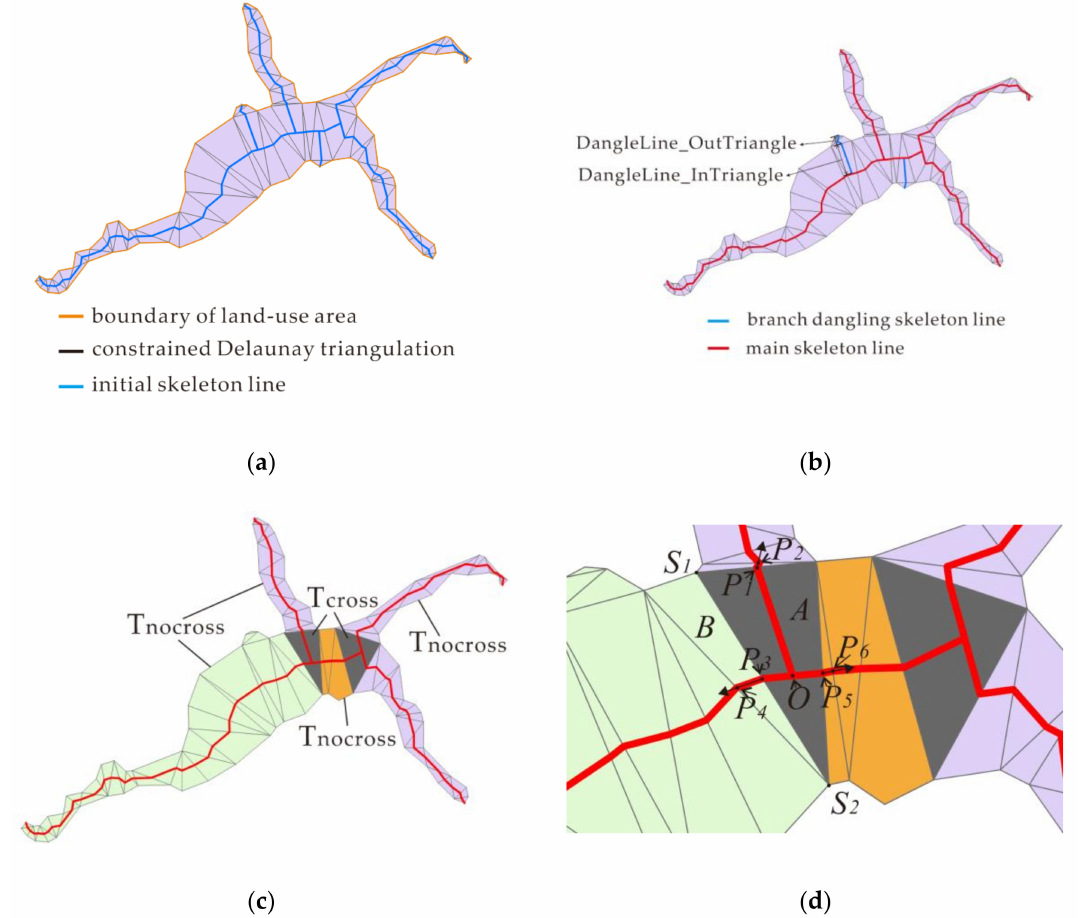
Figure 3. Branch extraction for a complex area. ( a ) Triangle network and skeleton line of a complex area. ( b ) Eliminating the branch dangling lines. ( c ) Identifying the branch triangles. ( d ) Determining the assignment of Type-III